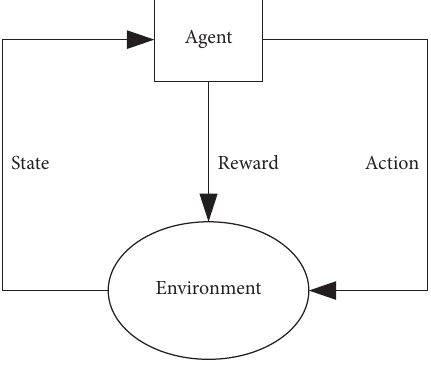
Figure 2: The interaction model of